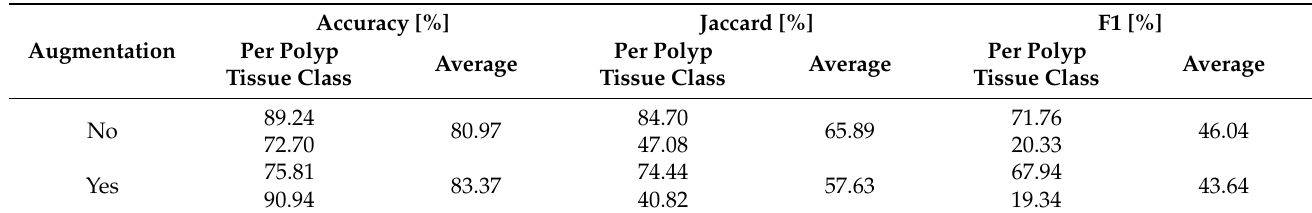
Table 10. Results for “Kvasir” dataset test using the model pre-trained on “CVC-ClinicDB”.